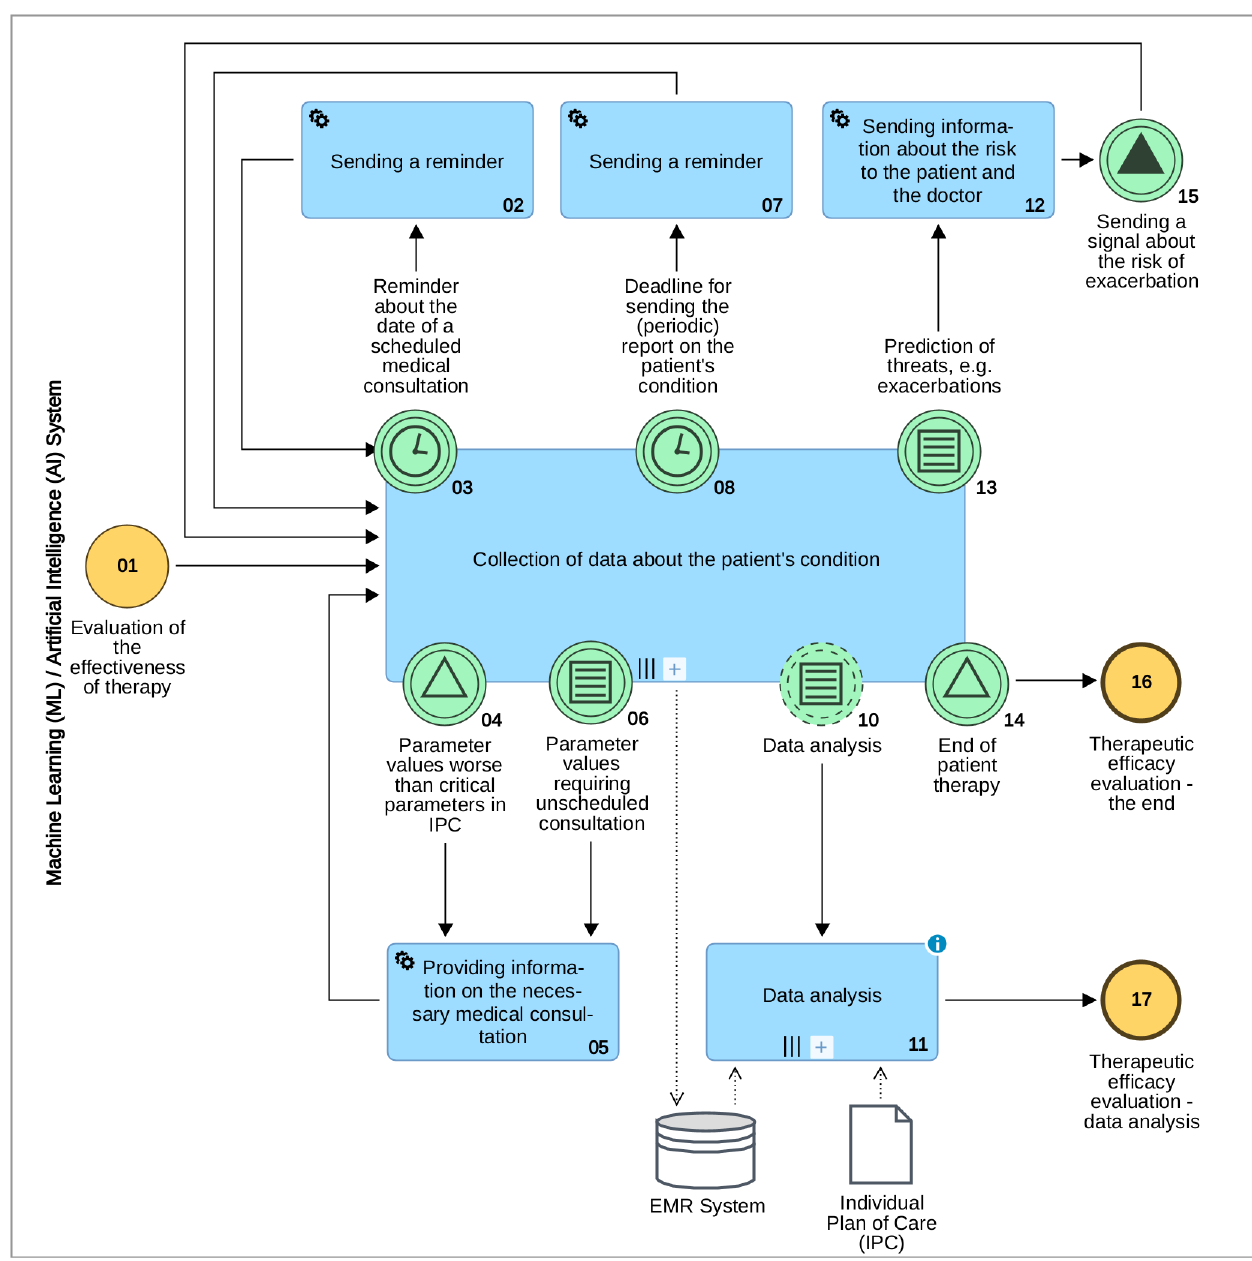
Figure 4. Diagram of the process Evaluation of the effectiveness of therapy (by